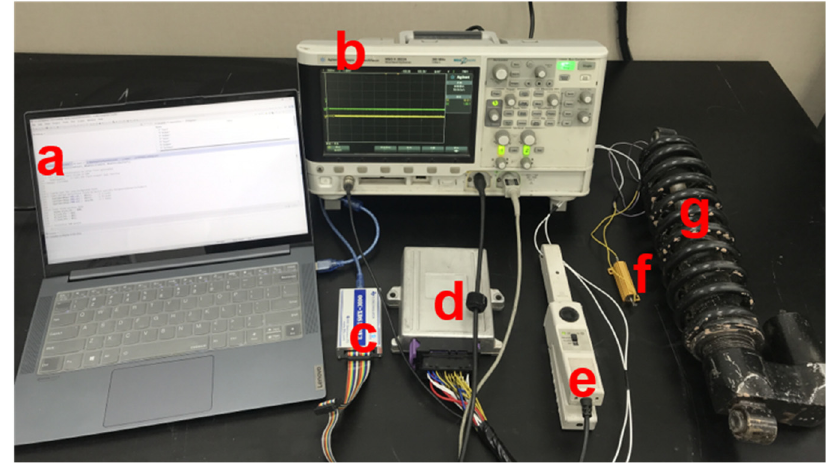
Figure 12. Schematic diagram of current driver test: ( a ) PC; ( b ) oscilloscope/signal generator; ( c ) JTAG; ( d ) current driver; ( e ) current probe; ( f ) load resistor 1 Ω ; ( g ) MRD.